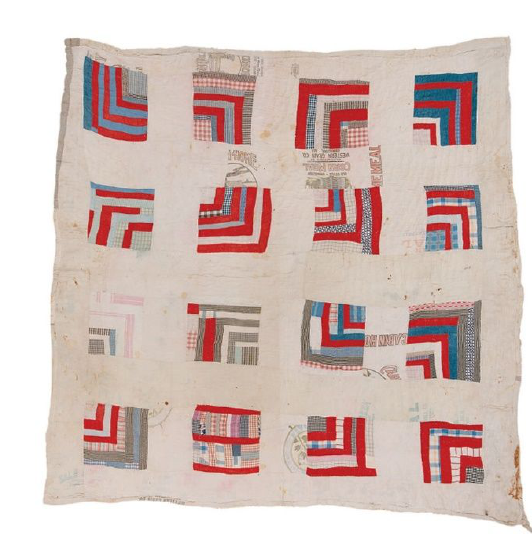
Figure 27 . Rachel Carey George, “Housetop —Sixteen-Block ‘Half-Log Cabin’ Variation Sashed With Feed Sacks,” ca. 1935. © 2022 Estate of Rachel Carey George / Artists Rights Society (ARS), New York. Photo by Stephen Pitkin/Pitkin Studio courtesy of Souls Grown Deep Foundation.